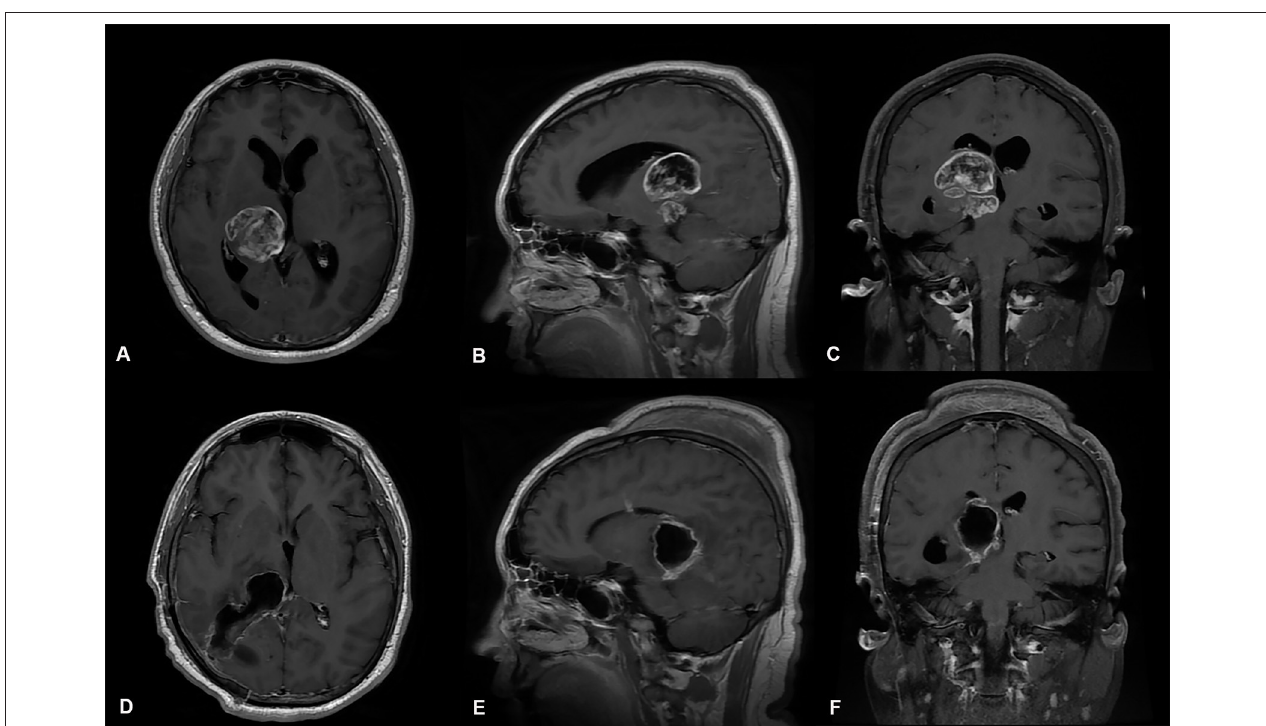
FIGURE 4 | Preoperative and postoperative imaging of thalamic malignant tumor resection with through parieto-occipital transventricular approach (A-C) display: Axial, sagittal and coronal enhanced MRI of malignant tumors of the right thalamus. The MRI shows that the main body of the tumor was located in the right thalamus; the supratentorial lateral ventricle and third ventricle were dilated. (D-F) display: MRI of thalamic tumor resection with the right lateral ventricular triangle approach. The images show total resection of the tumor; the volume of the lateral ventricle after surgical resection of the thalamic lesion did not